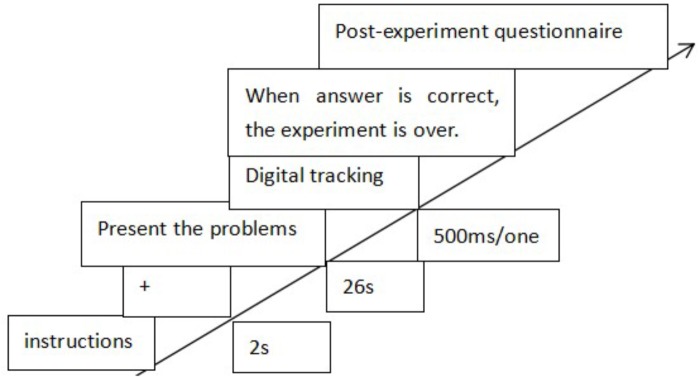
The procedures of Experiment 2a.